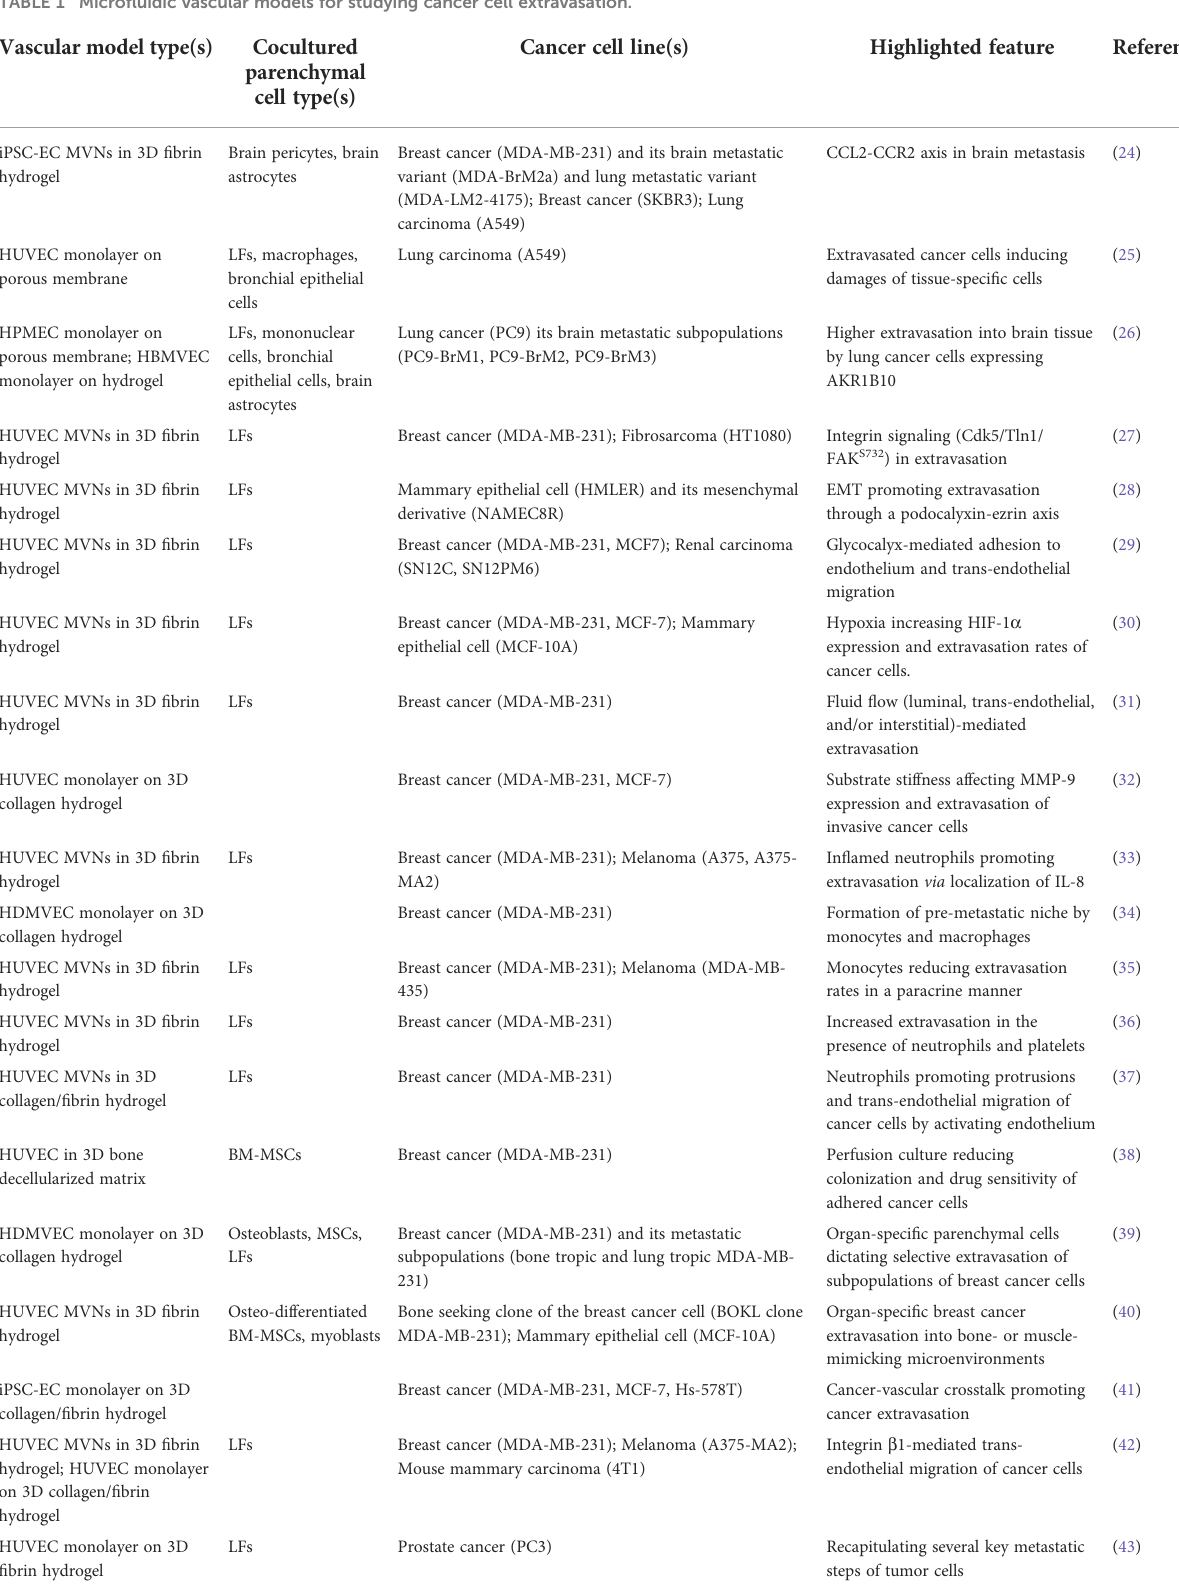
TABLE 1 Micro fl uidic vascular models for studying cancer cell